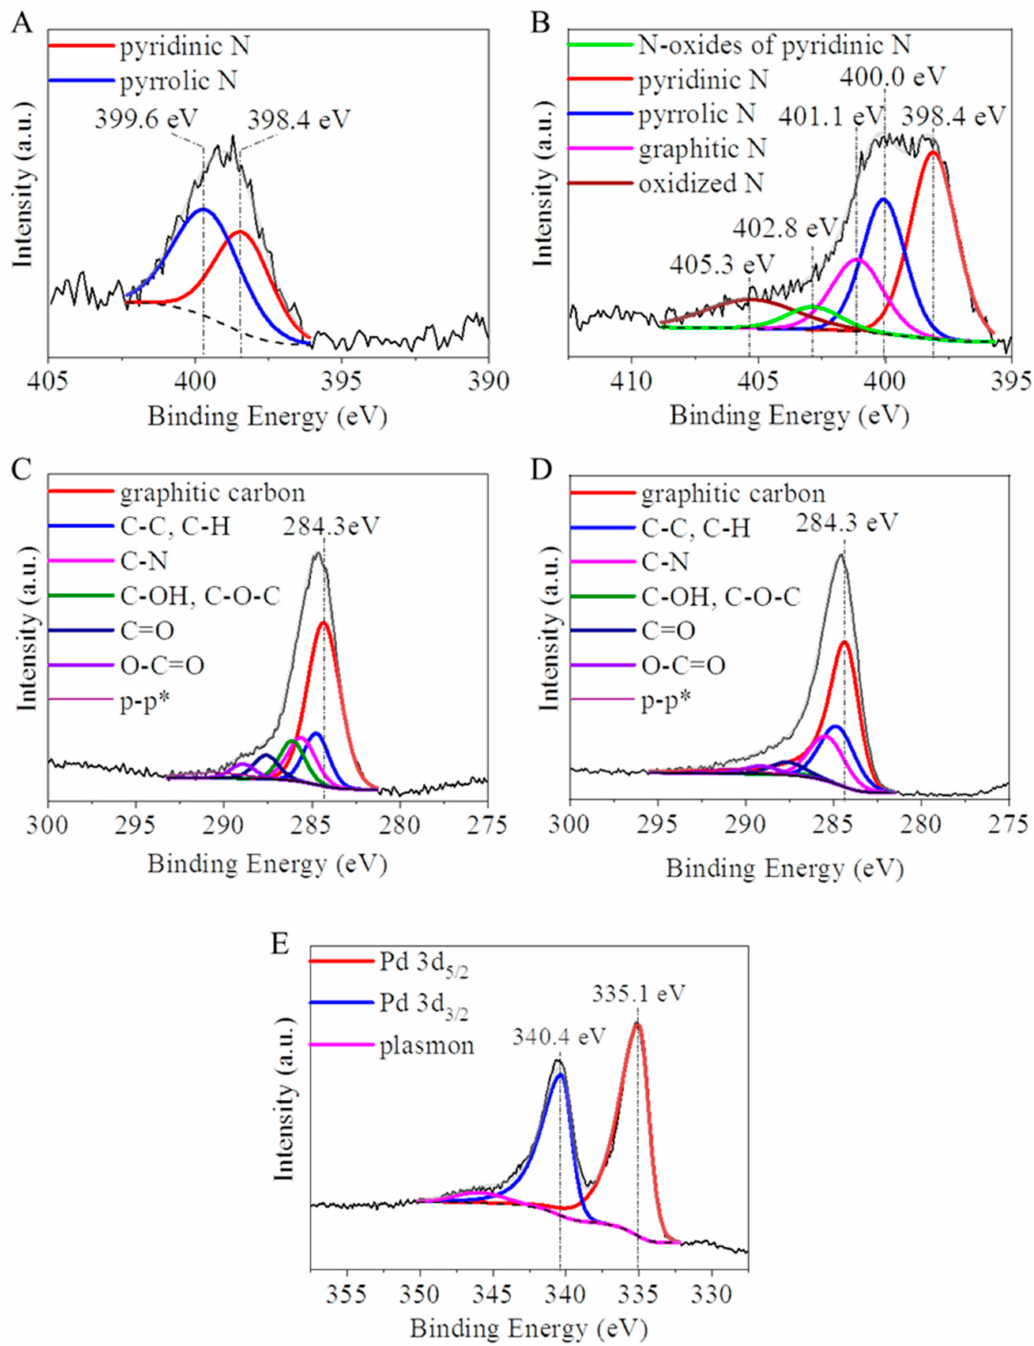
Figure 2. XPS spectra of the deconvoluted N 1s band of the non-activated carbon foil (CF) ( A ) and the Pd/CF catalyst ( B ) sample. The deconvoluted C 1s band of the non-activated CF ( C ) and the Pd/CF catalyst ( D ). Deconvoluted Pd 3d band of the Pd/CF catalyst ( E